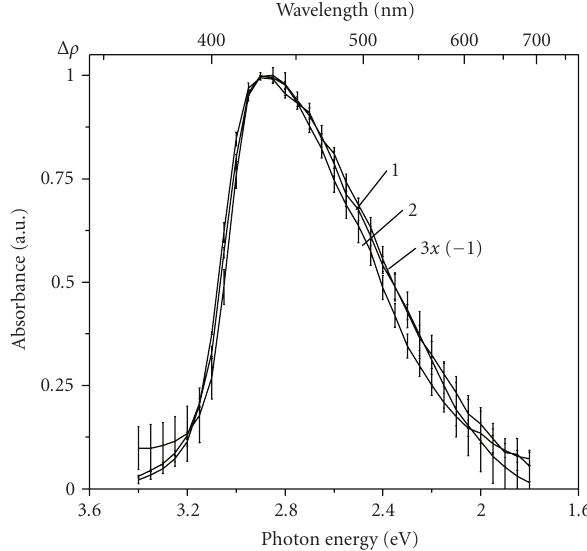
Figure 15: Averaged absorption spectra (1, 2) of various TiO 2 / polymer compositions normalized by Δ ρ max and averaged bleaching spectrum (3) of the TiO 2 /[P(VDF-HFP)] composition irradiated at di ff erent wavelengths. Reproduced with permission from [70]. Copyright (2007) American Chemical